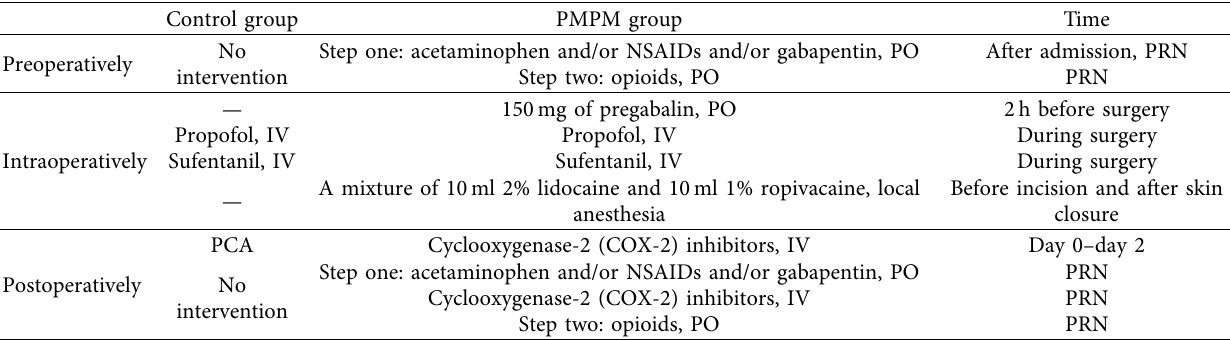
Table 1: Two different perioperative pain management